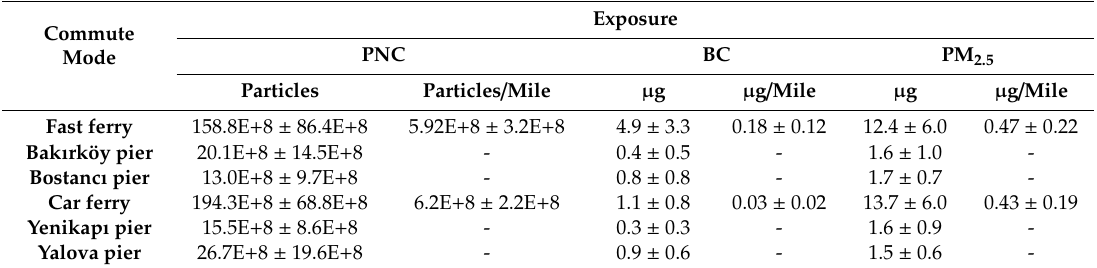
Table 6. Exposure concentrations of PNC, BC, and PM 2.5 for ferry and